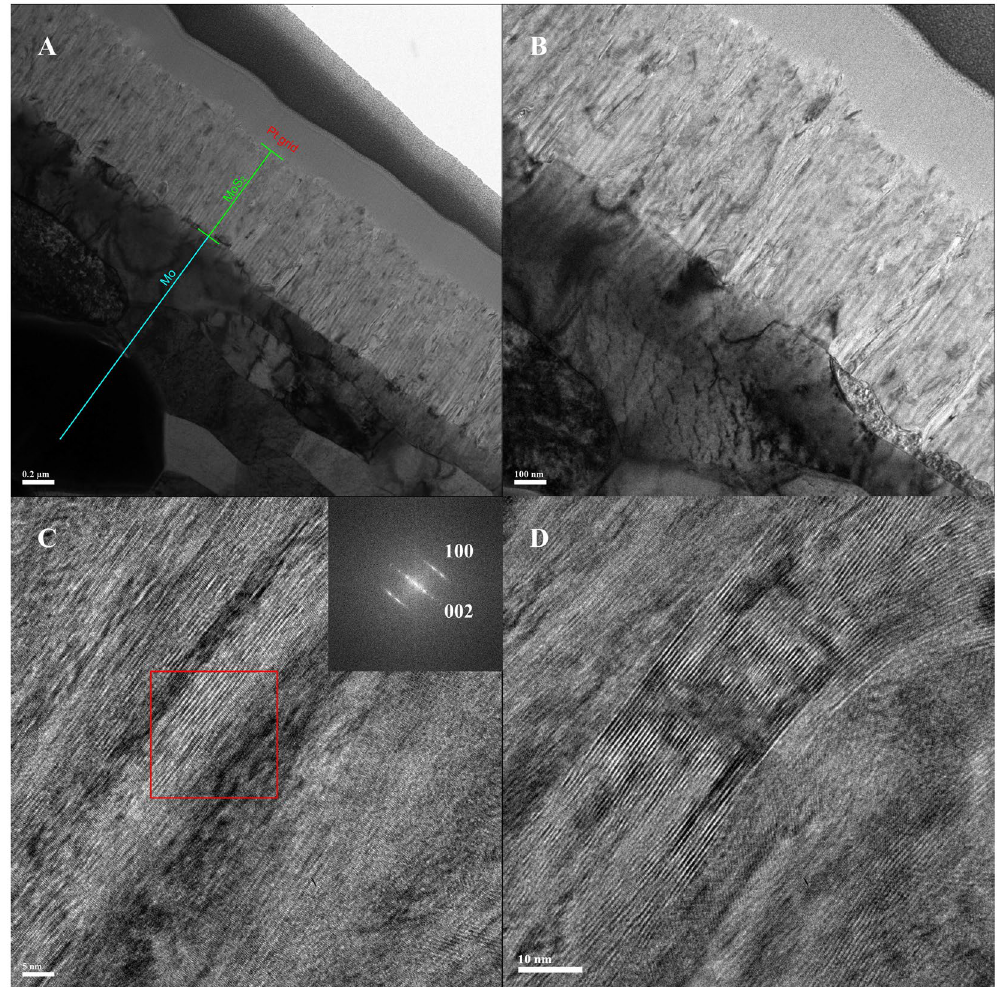
Figure 2. Transmission electron microscopy (TEM) images of VA-MoS 2 #1 grown on Mo foil with different magnifications ( A , B ); high resolution TEM (HRTEM) of several areas and FFT from the selected red square ( C , D and